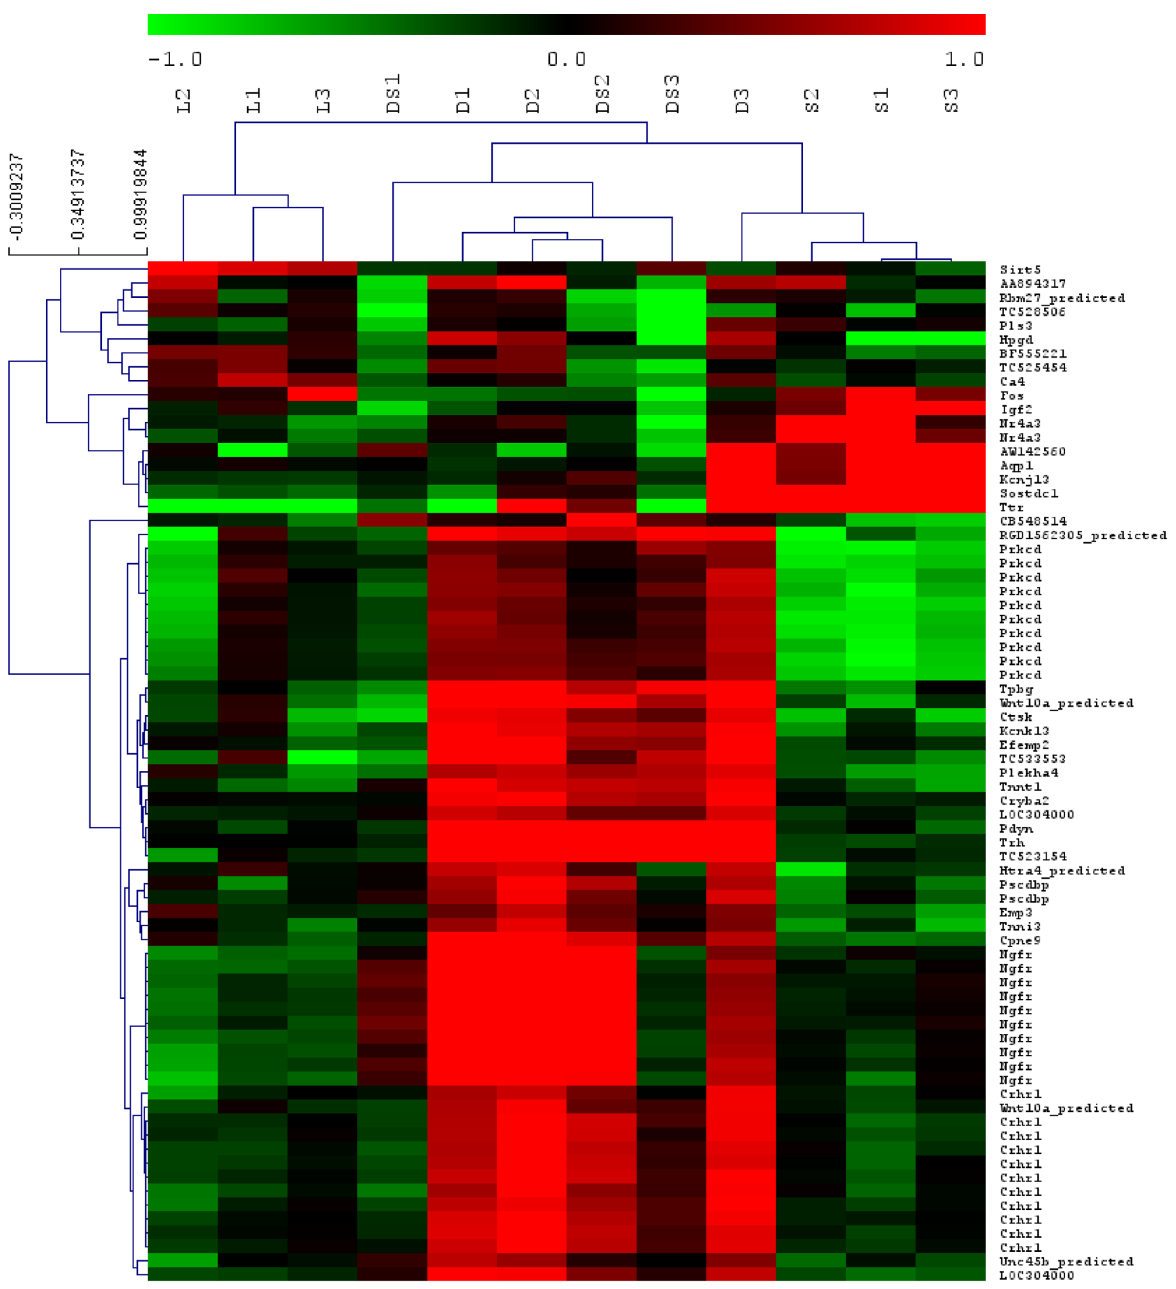
Figure 3. Hierarchical clustering. The 12 experimental striatal samples were: L1, L2 and L3 (6-OHDA); S1, S2 and S3 (HFS); D1, D2 and D3 (DOPA) and DS1, DS2 and DS3 (DOPA/HFS). The hierarchical clustering was constructed with the genes showing significant changes after a 4 group Sam analysis on the genes with expression value above detection limit in at least 40% of the samples. Upregulated and down-regulated genes appear in red and in green, respectively, with the relative log2 (ratio) reflected by the color intensity. Three sample clusters were found: 6-OHDA, DOPA with DOPA/HFS and HFS. doi:10.1371/journal.pone.0060447.g003 C delta type), slc18a2 (vesicular monoamine transporter 2), trpc4 The up-regulation of Ttr, Sostdc1 and Igf2 was verified by RT- (short transient receptor potential channel 4). To note that emp3 and PrKcd were inversely regulated by HFS and by DOPA. (1.4-fold) up-regulation of Chrna7 (nicotinic receptor alpha 7 From the genes significantly altered in HFS group vs 6-OHDA (Table S3), 5 displayed a more than 2-fold increase: Ttr (transthyretin), Sostdc1 (sclerostin domain containing 1), Aqp1 (aquaporin 1), Nr4a3 and Igf2 (insulin growth factor 2); Ttr and Sostdc1 showing the highest fold change: 279 and 26, respectively.